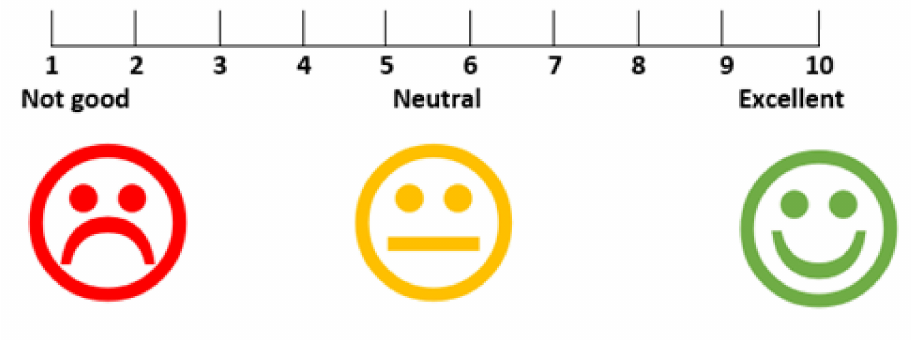
Figure A1. Supportive visual for Connecting